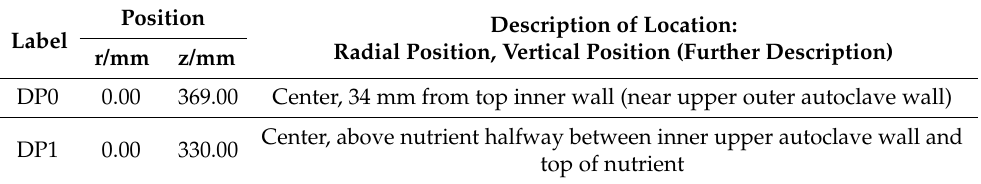
Table 2. Detailed description of domain probes, including the labels used, radial and vertical position, and description of